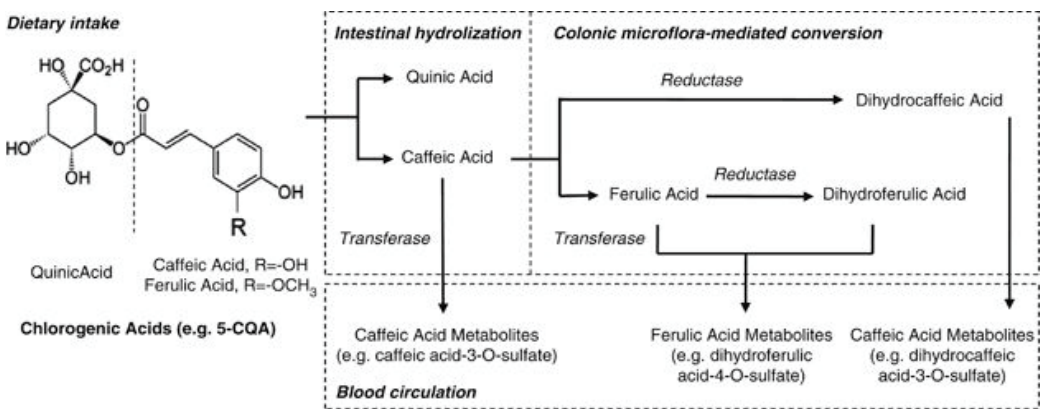
Figure 3. Main metabolic pathway of chlorogenic acids. Dietary chlorogenic acids is hydrolyzed into quinic acid, caffeic and ferulic acid, and further metabolized in small intestine and colon before entering into blood stream (Adapted from reherence Zhao et al., 2012) [87].